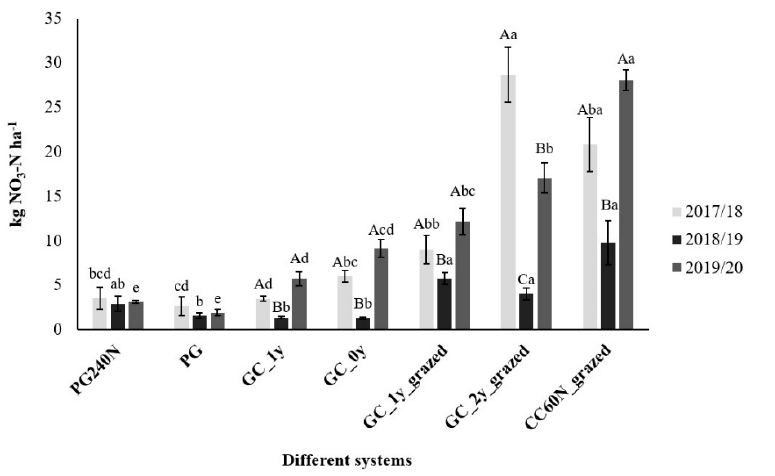
Figure 2. Average nitrate leaching losses (kg NO 3 -N ha − 1 ) of the different systems investigated over three experimental years (2017/2018, 2018/2019 and 2019/2020). Different upper-case letters indicate significant inter-annual differences. Different lower-case letters indicate significant differences between the various sward types. Standard errors are shown.